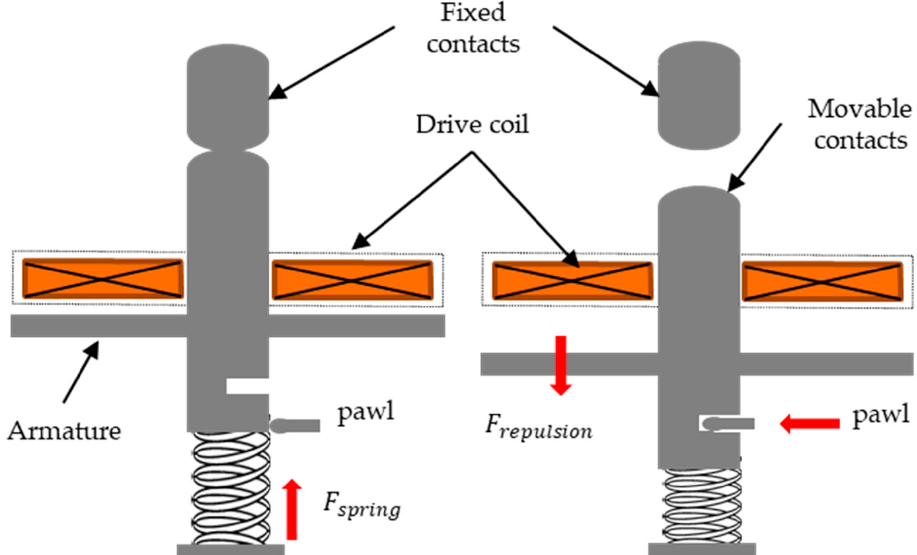
Figure 5. TCA utilizing a spring holding mechanism, redrawn as depicted in [48].